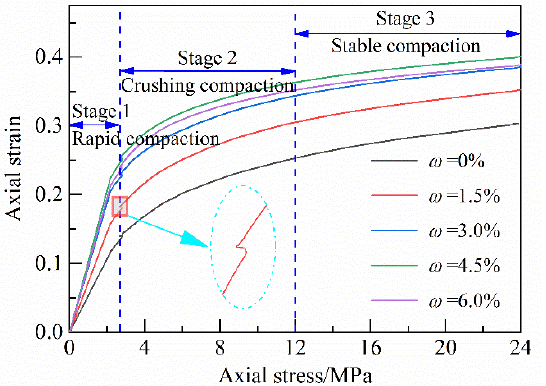
Figure 5. Strain–stress curves of crushed gangue under different water content conditions. (1)